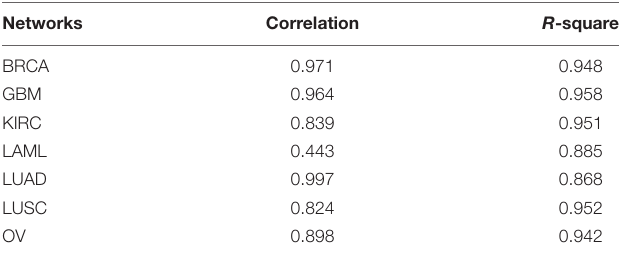
TABLE 2 | Correlations and R-squares of the power-law fitting in the seven networks. Networks